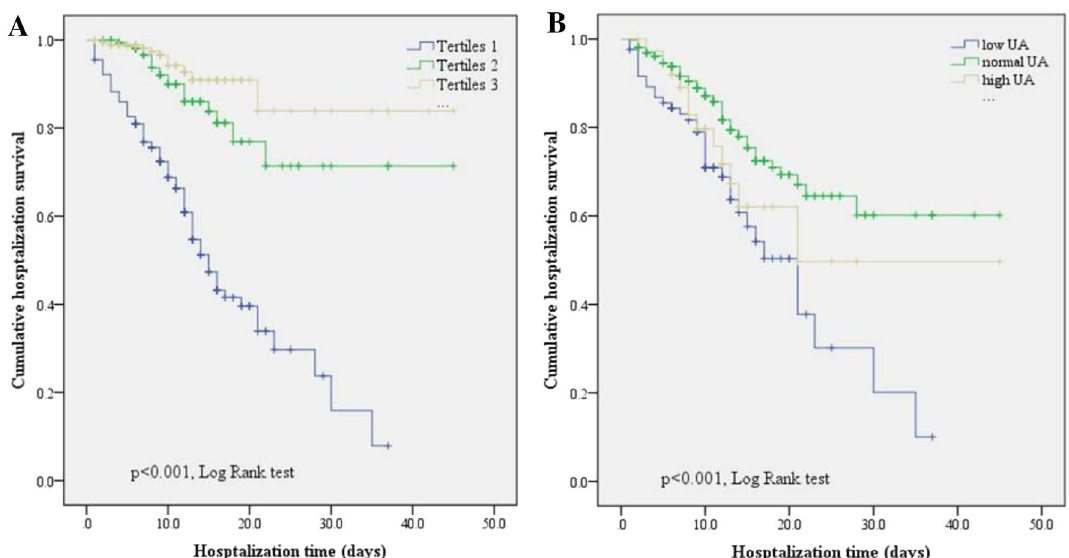
Figure 2. Kaplan–Meier curves stratified according to the lowest and admission UA level. Log-rank testing revealed a significant decrease between tertiles 1 group with other two groups ( A ). The mean survival time of the normal group was significantly higher than that in the low and high groups ( B